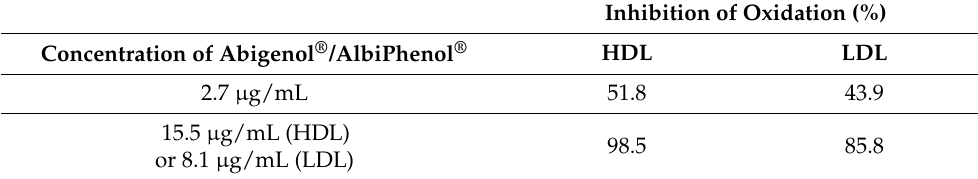
Table 2. Inhibition of oxidation (%) for HDL and LDL in the presence of the extract compared to the controls (proteins without the